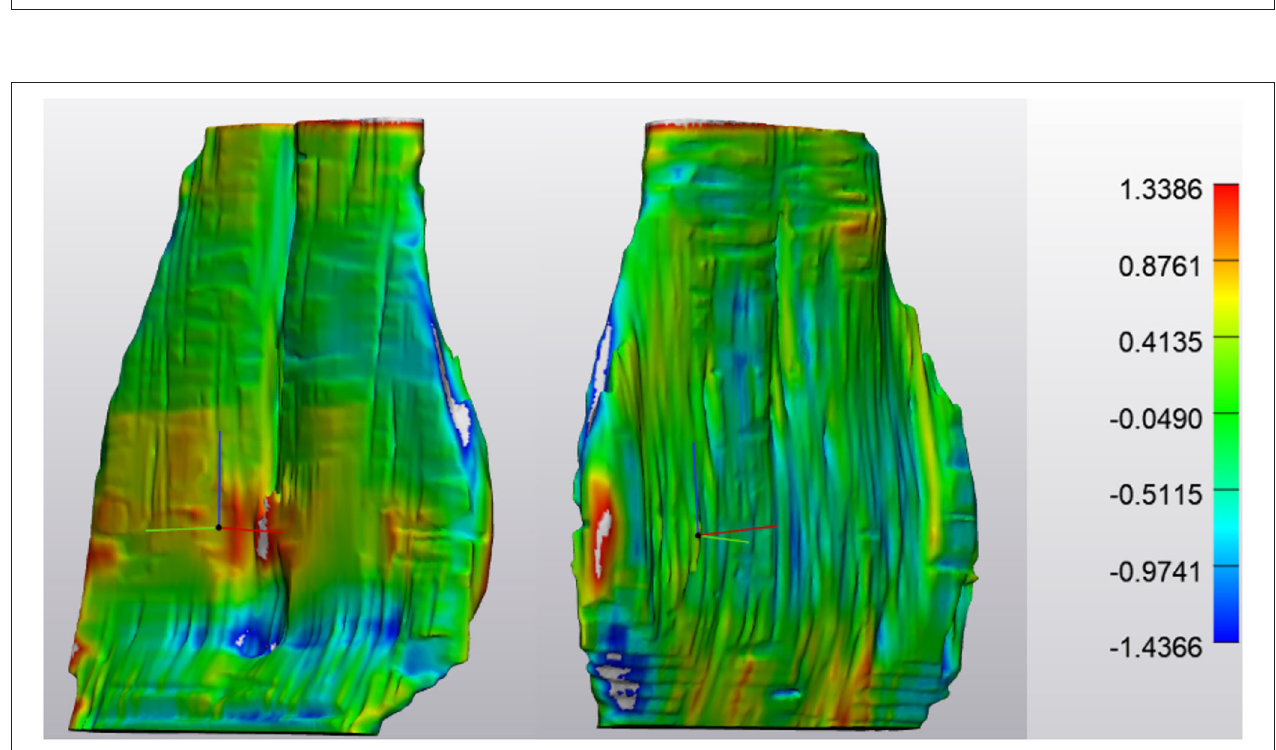
FIGURE 3 | NORMAL Deep Digital Flexor Tendon. Analysis of the change in tendon size in one horse over 7 months (prior to application of wrapping and smoothing algorithms). Size change is limited to + 1.3386 or − 1.4366mm. No significant pattern is observed. (Left) Obliqued dorsal view. (Right) Obliqued palmar view. Top of the image represents the proximal aspect of the